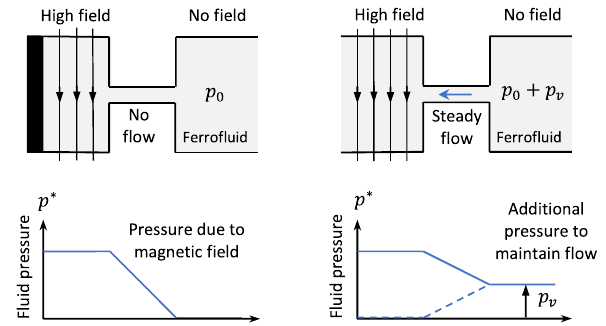
Figure 1. Illustration of pressure components due to applied magnetic field, both with and without fluid flow.